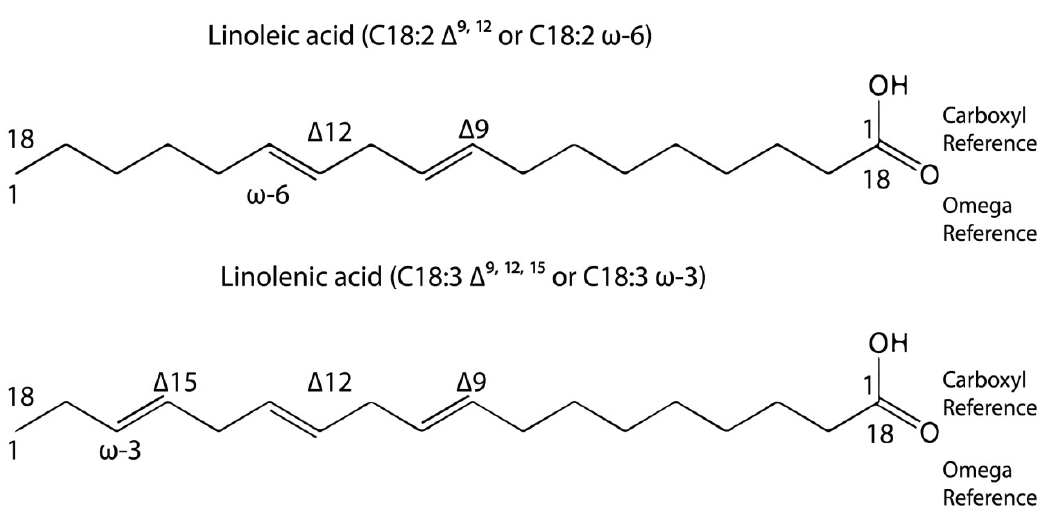
Figure 1. IUPAC and omega